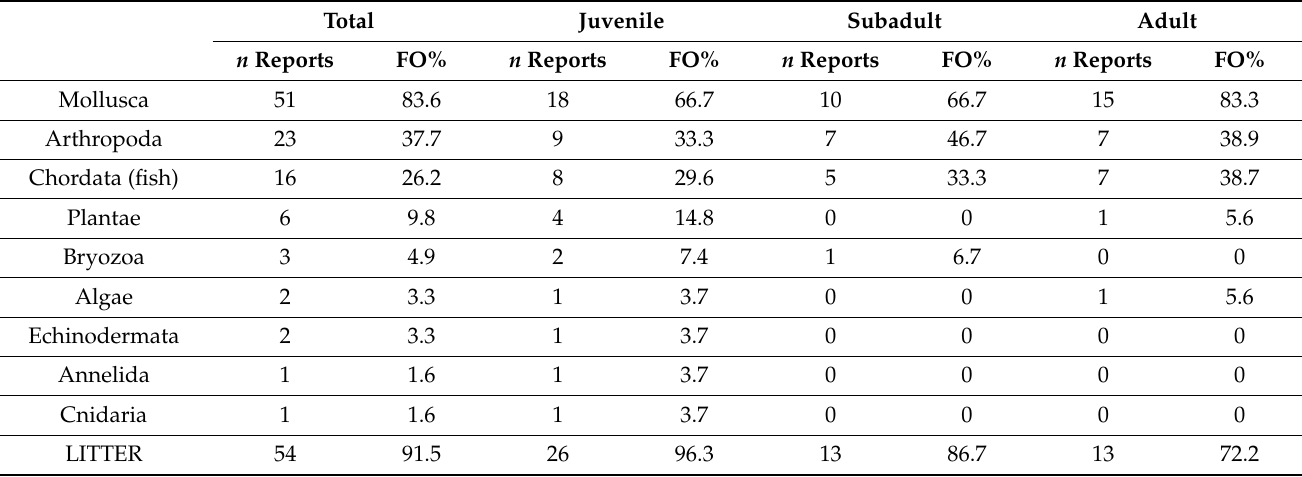
Table 2. Frequency of occurrence of food and litter ingestion in loggerhead sea turtles from the Tyrrhenian Sea: number of reports and FO% per phylum in the groups of juveniles ( n = 27), subadults ( n = 15), and adults ( n =